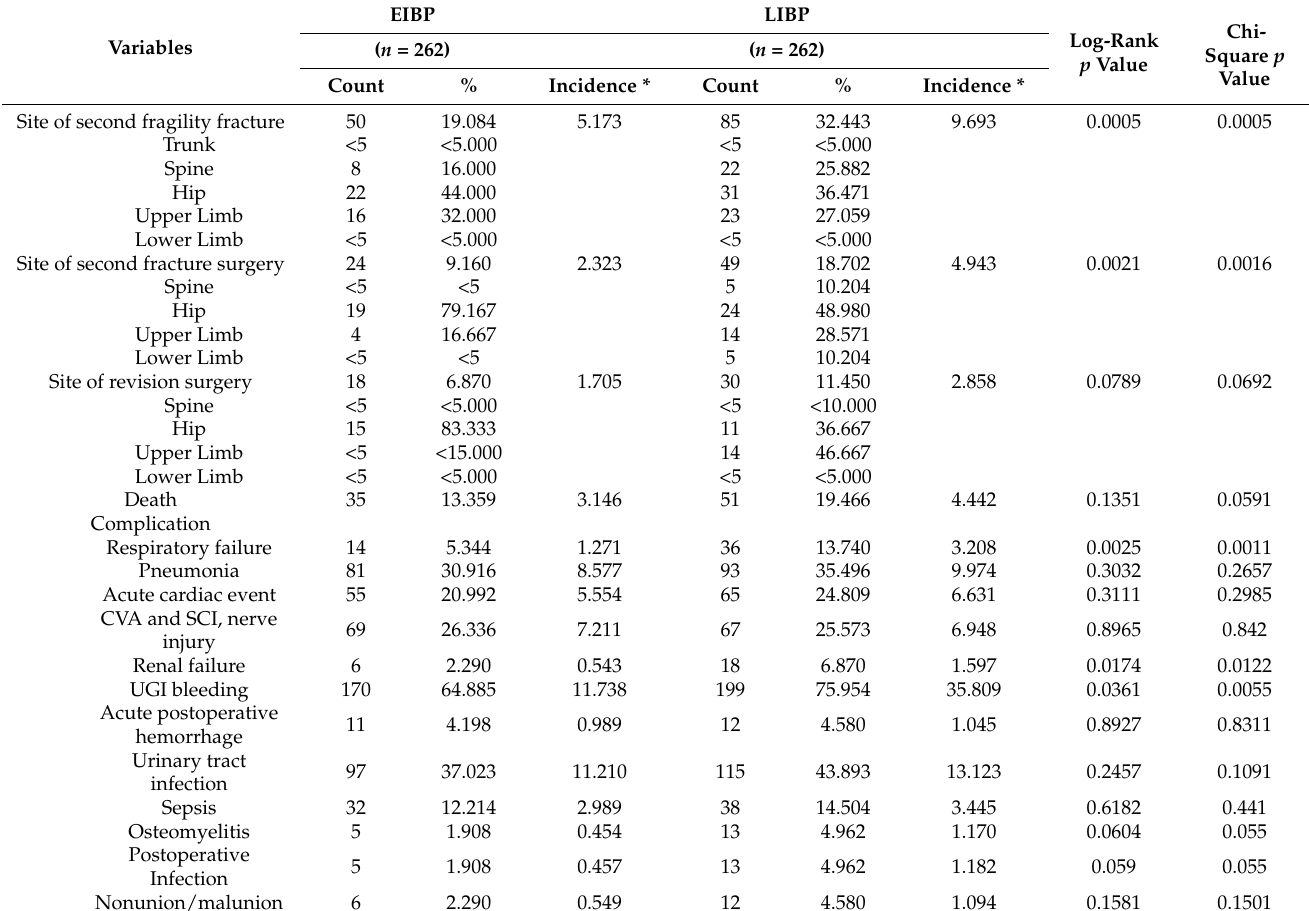
Table 2. Incidence of second fragility fractures and surgeries, revision surgery, death, and complications.